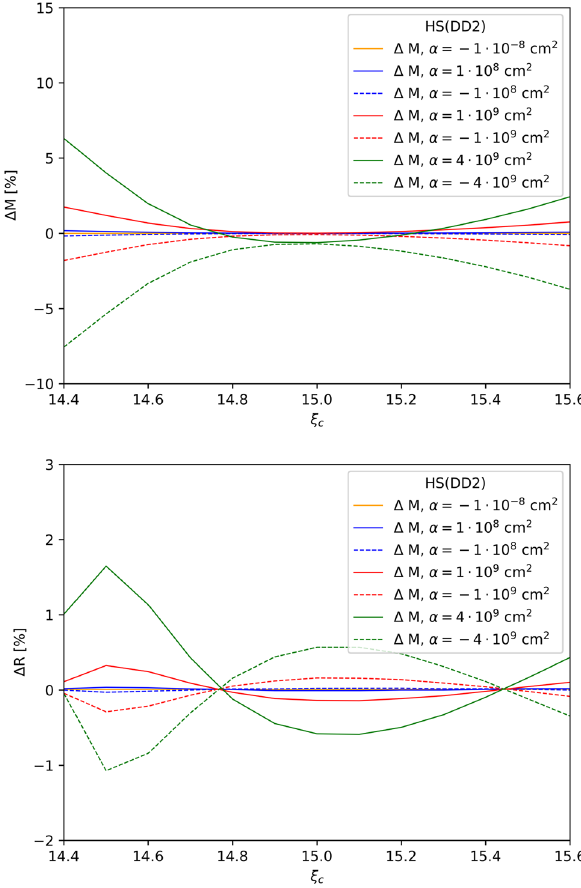
Fig. 5 Differencebetweenthemass(upperpanel)andtheradius(lower panel) obtained, given a central density value ξ , with f ( R , Q ) = R + α R 2 and GR, for the FPS EoS